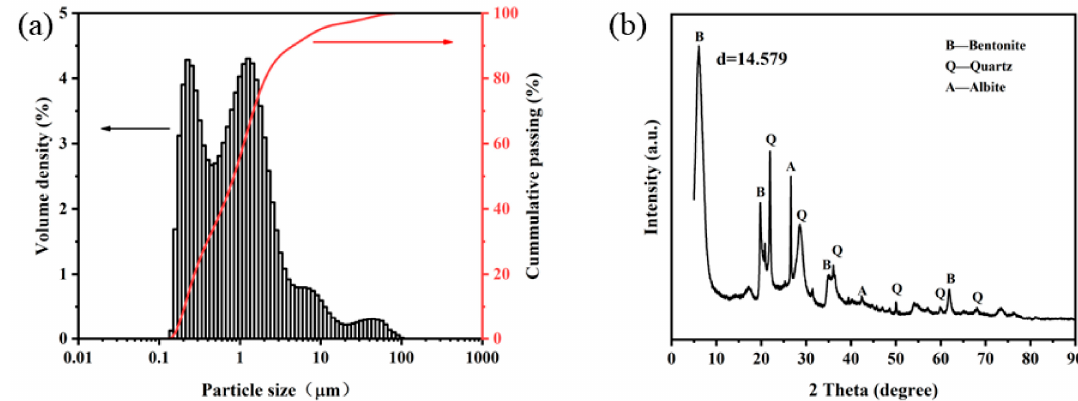
Figure 4. ( a ) Particle size distribution; ( b ) XRD pattern of montmorillonite sample.